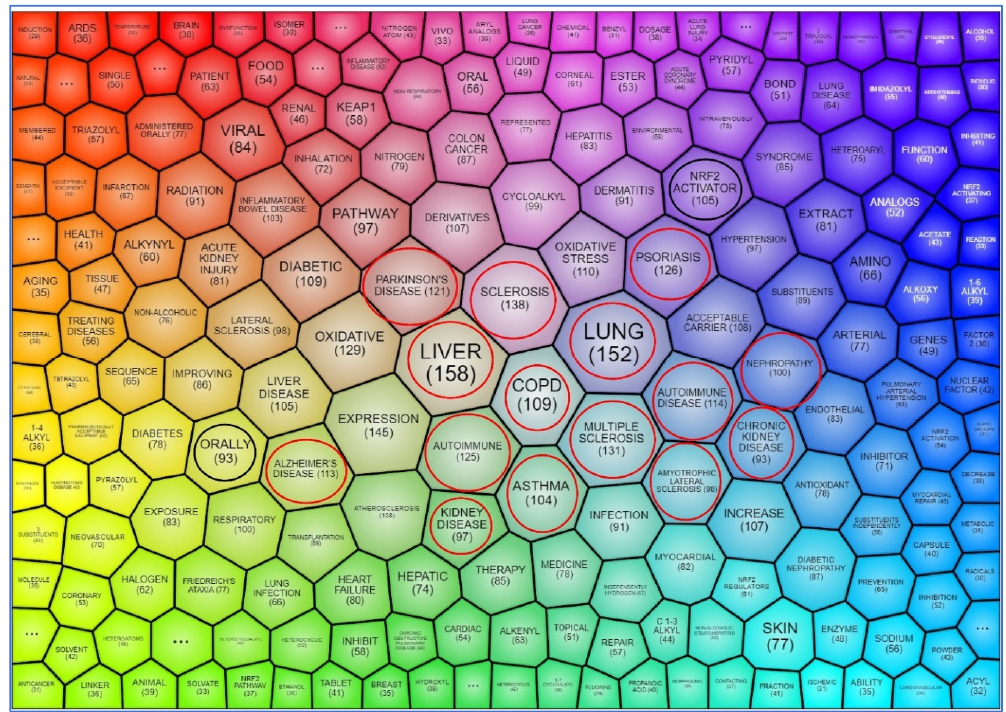
Figure 4. Clustering of the most common keywords found in Nrf2-related patents (in title, abstract, and full claims) published from January 2017 to May 2020, using PatSeer Pro. Numbers indicate the patents featuring each respective keyword. Red circles indicate keywords relevant to the topics shown in Figure 3, and black circles indicate Nrf2-modulating compounds and their route of administration.